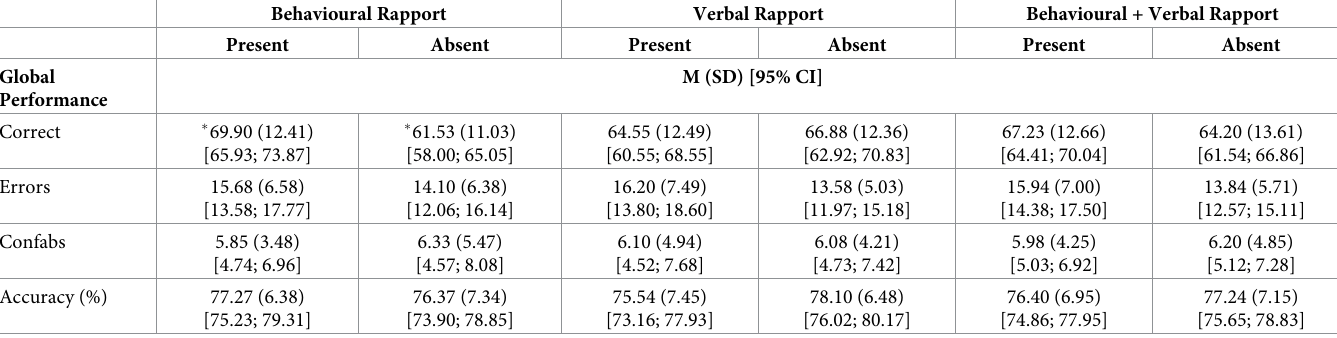
Table 5. Mean (standard deviations [95% confidence intervals]) main effects and interactions for global correct information, incorrect information (errors), con- fabulations (confabs) and accuracy ( � = p <